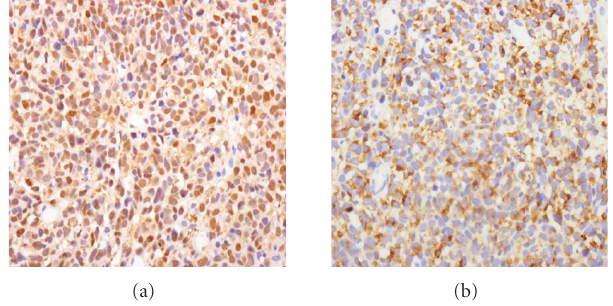
Figure 4: Immunohistochemical stain. The cells sporadically showed immunoreactivity for S-100 protein ( × 400, a) and HMB- 45 antibody ( × 400,